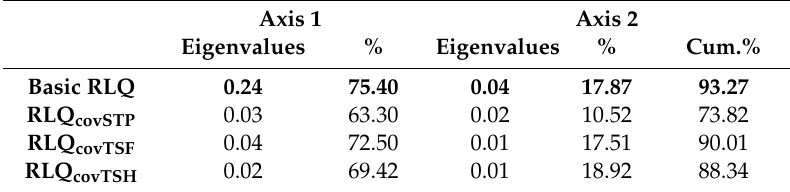
Table 5. Eigenvalues, percentage, and cumulative percentage of variance explained by the first two axes of the basic RLQ and the partial RLQ at the fine scale. Axis 1